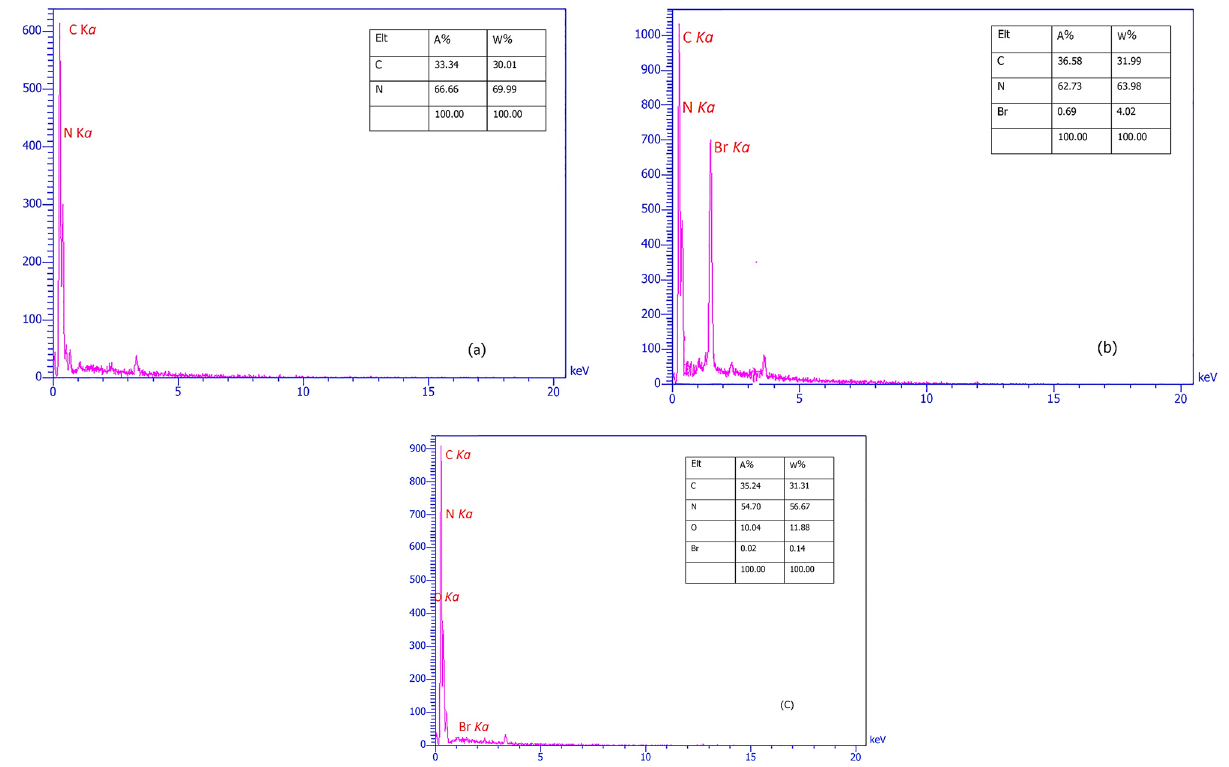
Figure 4. EDX spectrum of (a ) nanosheets g-C 3 N 4 , ( b ) modified g-C 3 N 4 , ( c ) g-C 3 N 4